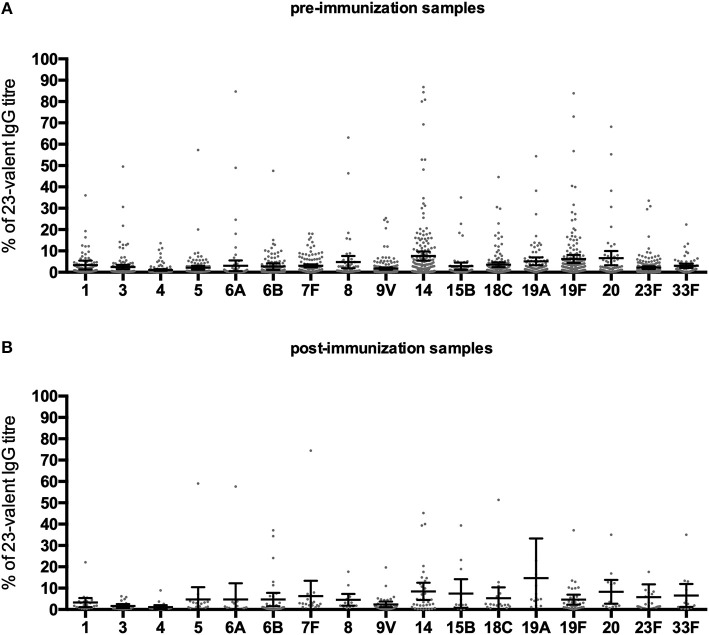
Percentage that a serotype contributed to the 23-valent IgG titer in pre-immunization samples (A), and post-immunization samples (B) in Pn-C vaccine-naïve patients. Error bars represent mean percentages +95% CI.